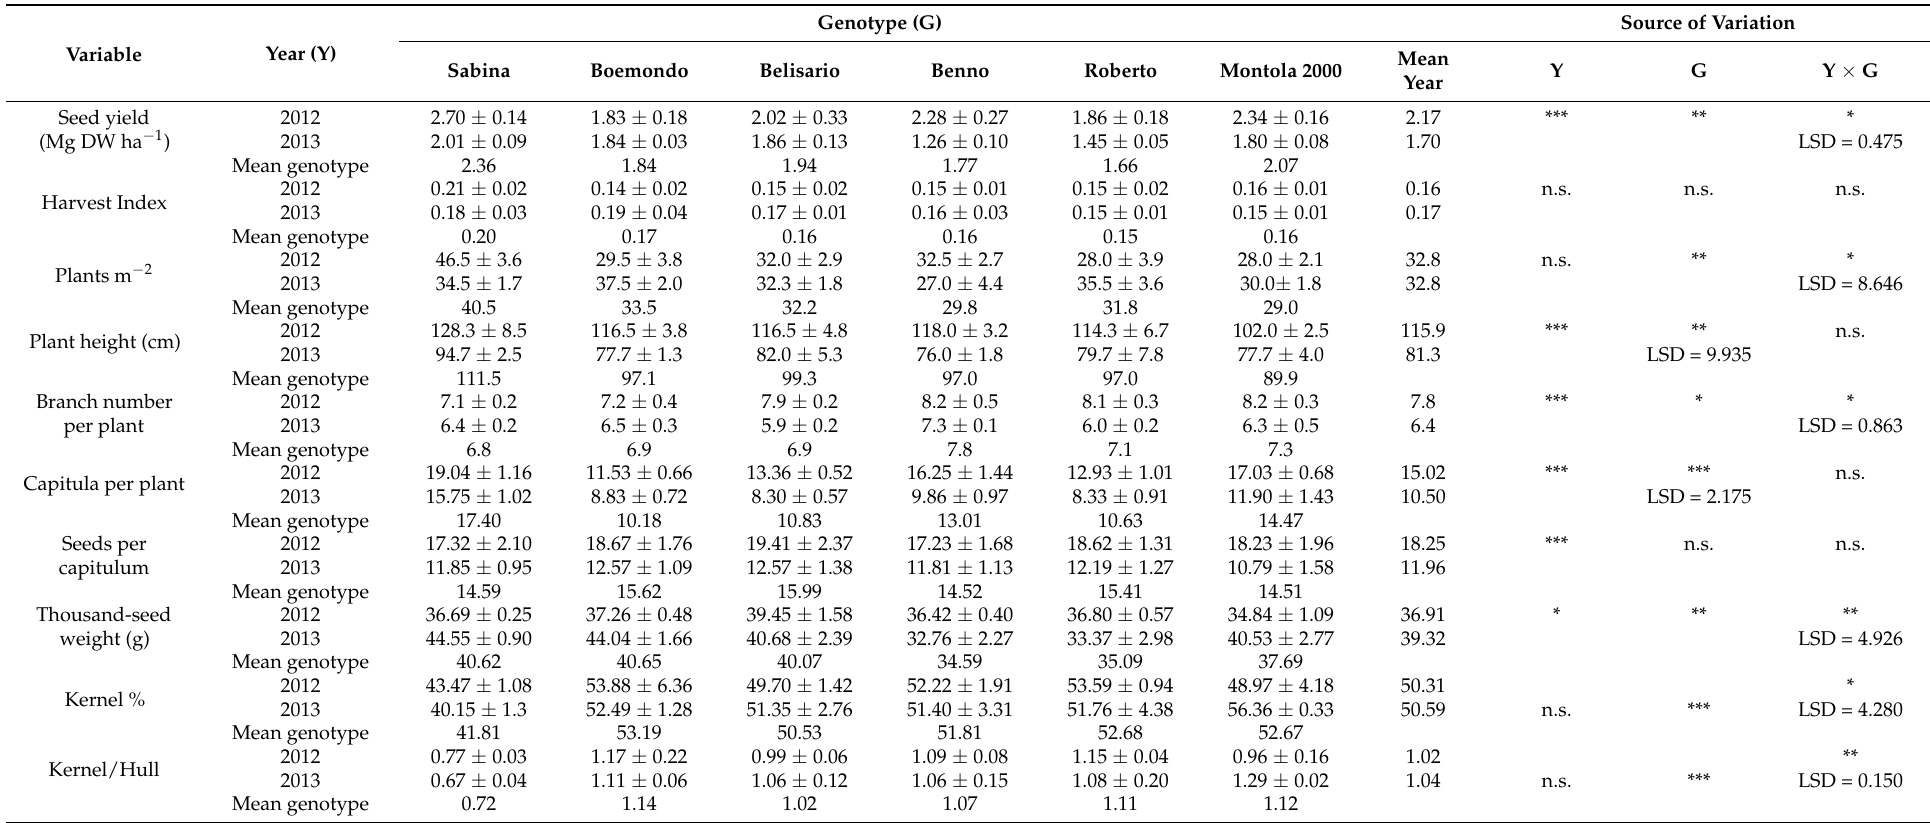
Table 5. Main biometric and productive characteristics (means ± SE) of six safflower genotypes sown in spring during two consecutive growing